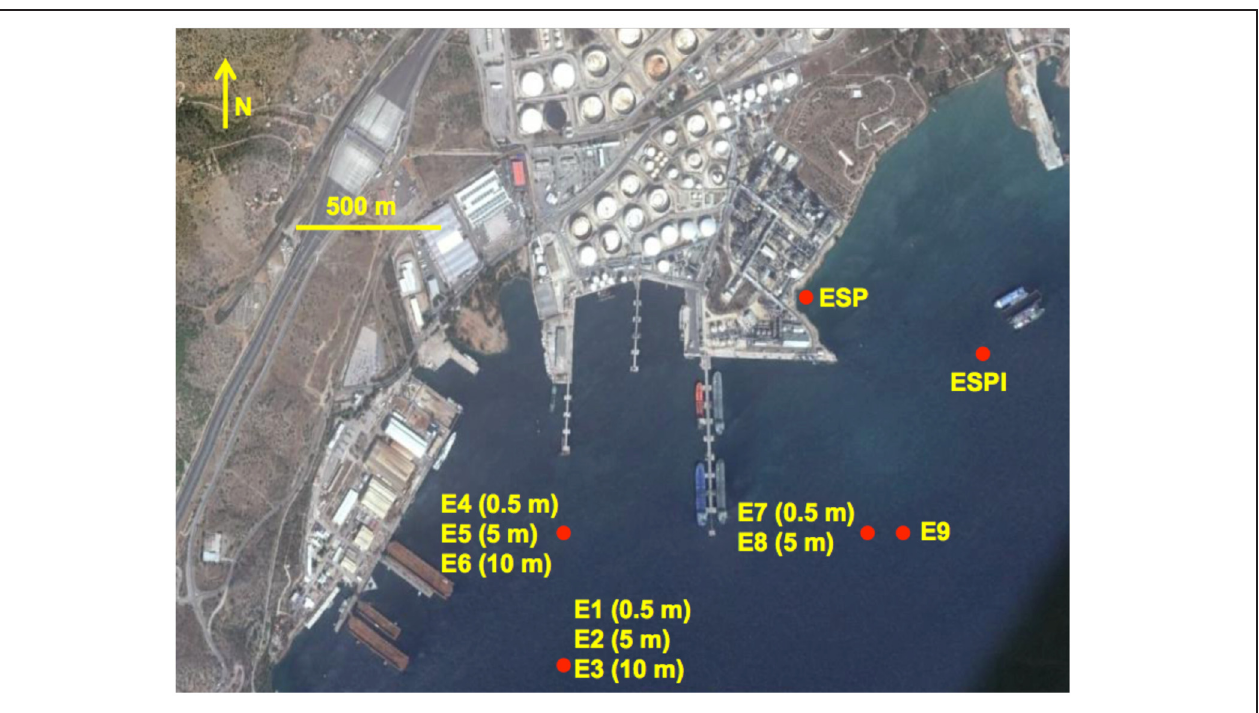
FIGURE 1 | The sampling campaign map. The locations of all the sampling sites are represented by red dots. The code(s) of the consortia isolated from each sampling site is given next to each dot. For consortia isolated from the